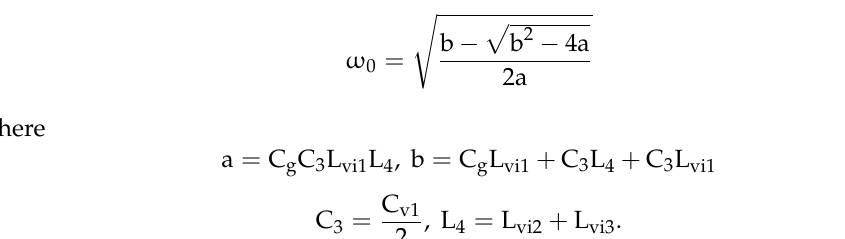
Figure 3. The equivalent circuit of the proposed resonator.